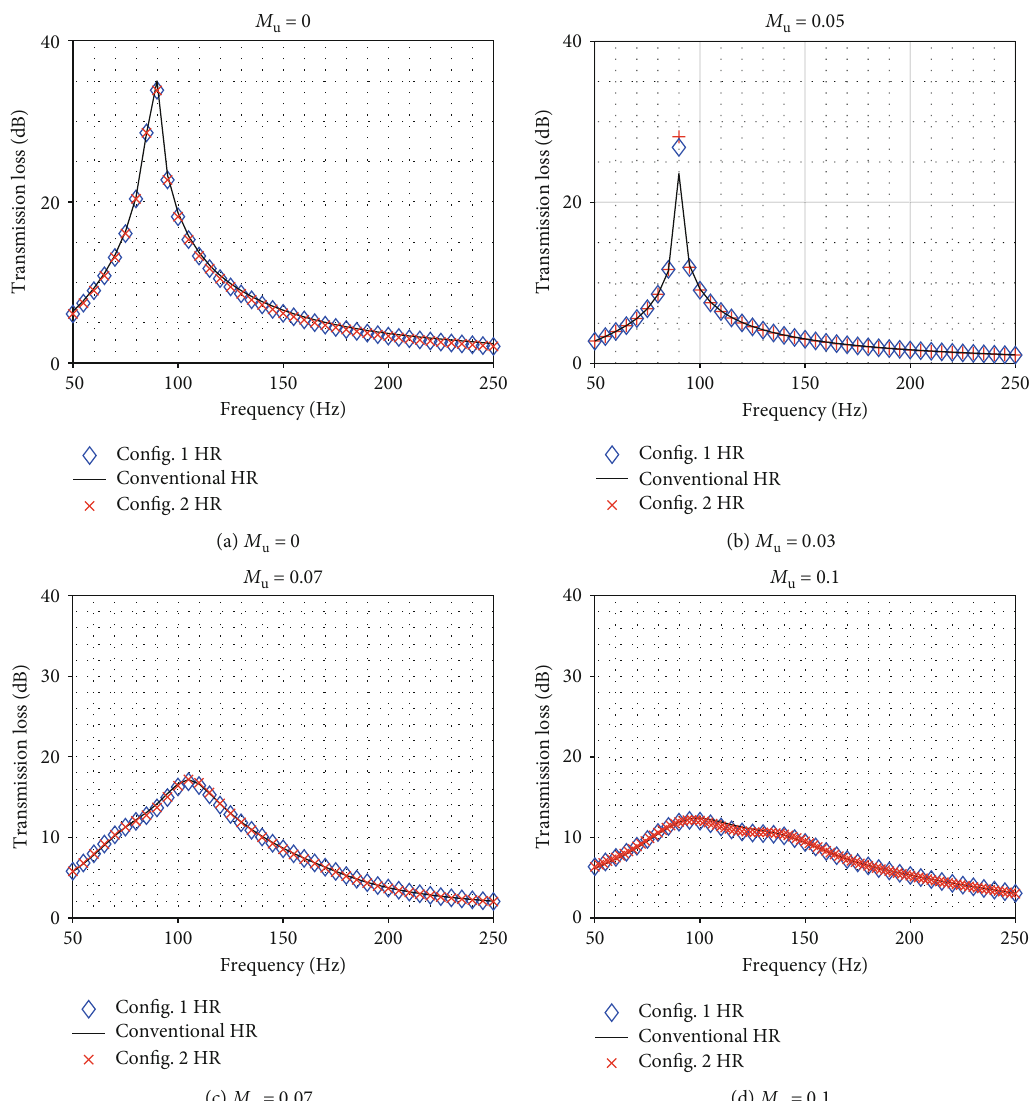
Figure 4: Comparison of transmission loss with a rigid ba ffl e implemented in di ff erent con fi gurations. Con fi g. 1: H Con fi g. 2: H